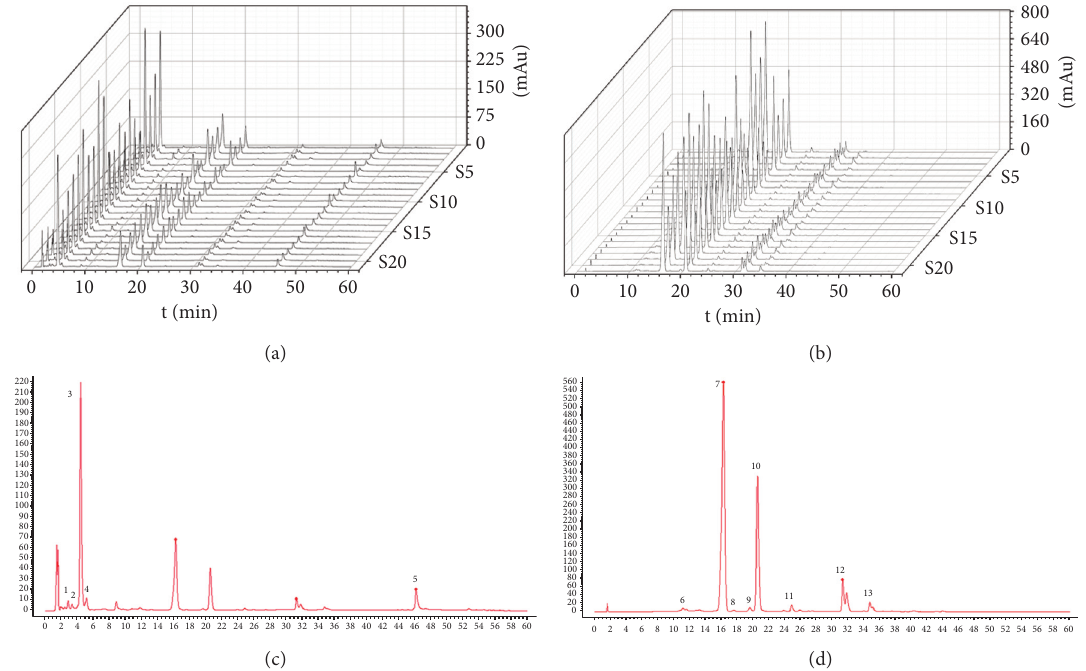
Figure 2: HPLC fingerprints of 21 batches of saffron at 257nm (a) and 440nm(b) as well as representative fingerprint of saffron at 257nm (c) and 440nm